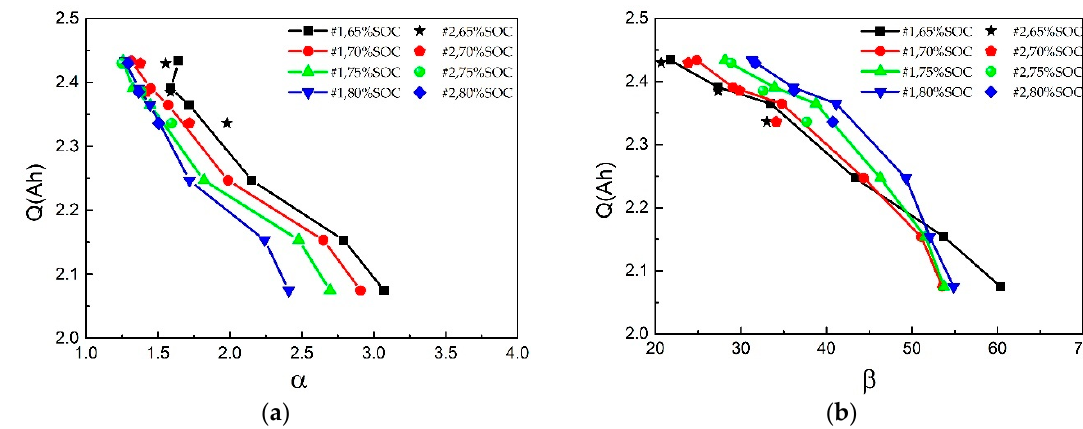
Figure 12. Relationship between relaxation voltage model parameters and capacity at 65%, 70%, 75%, and 80% SOC under charging condition of cell #1 and #2. ( a ) results of α ; ( b ) results of β .